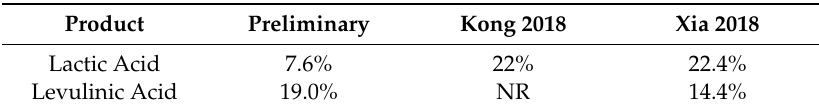
Table 1. Preliminary yield of major acid products formed from glucose using impregnated Sn-Beta compared to postsynthesis Sn-Beta [22,23] (NR = Not